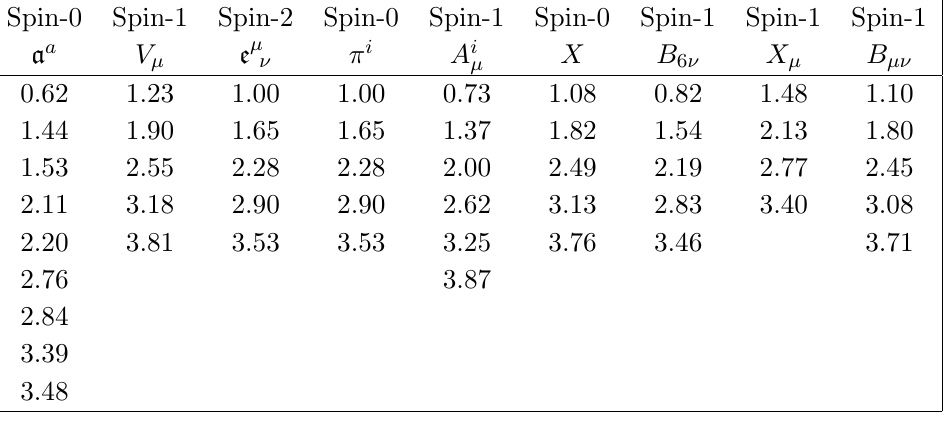
log3 IR = (cid:0) 4